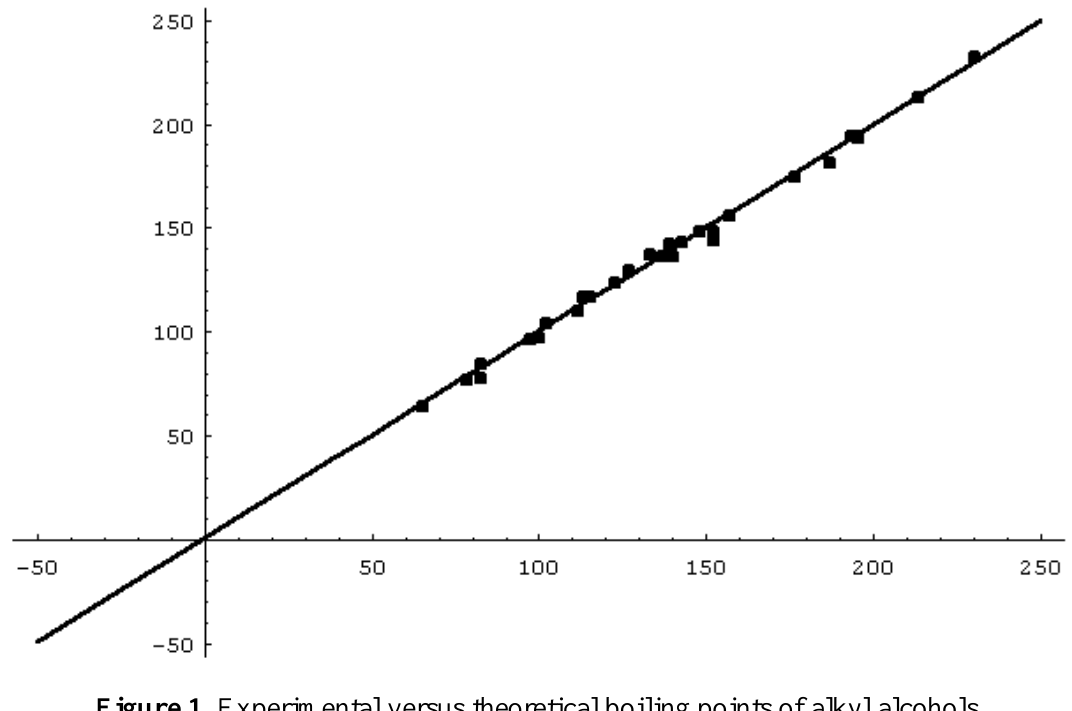
Figure 1. Experimental versus theoretical boiling points of alkyl alcohols. Table 3. Experimental and calculated boiling points ( ° C) of alkyl